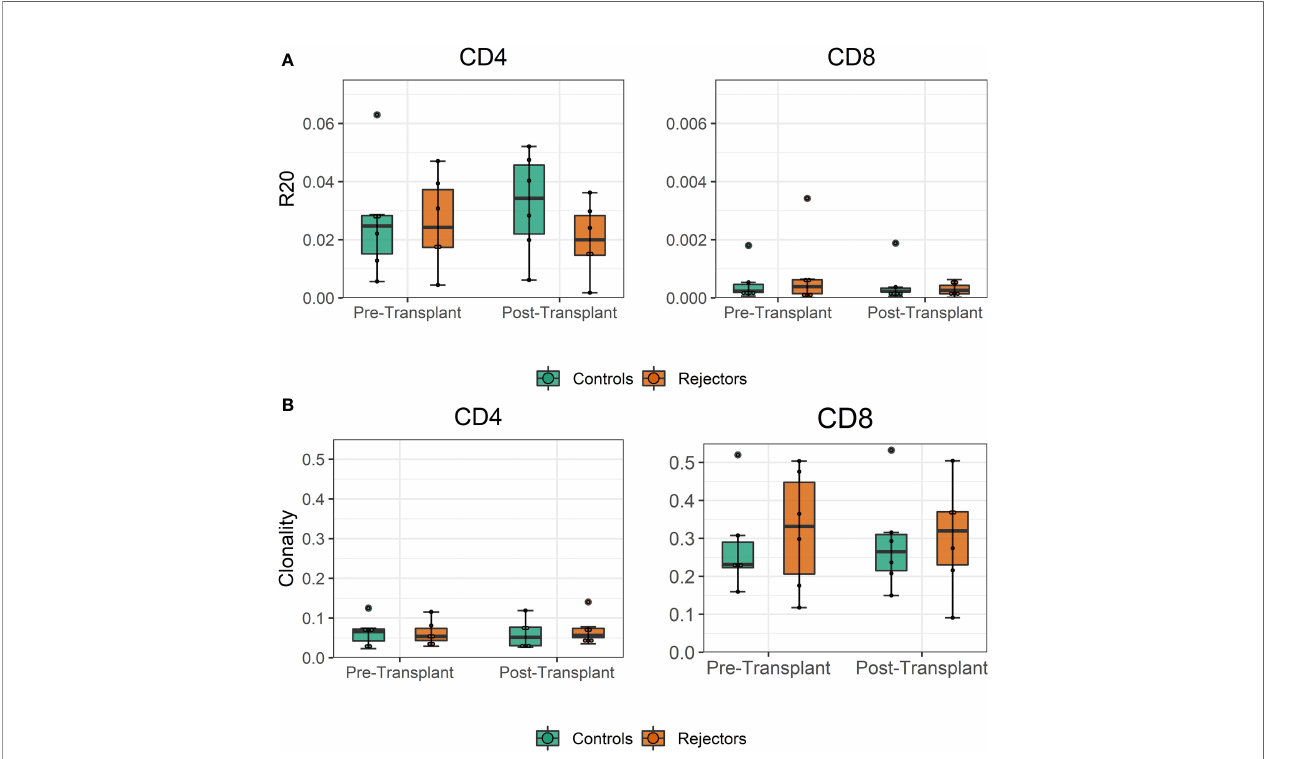
FIGURE 4 | (A) Boxplot of clonality estimates of the pre- and post-transplant repertoire samples grouped by rejection. (B) Boxplot of R20 estimates of the clonotypes in the pre- and post-transplant repertoire samples grouped by rejection. No signi fi cant difference in diversity of the circulating TCR repertoire is detected between rejecting patients and control group assessed by two-sample Student ’ s t-tests (n = 12).